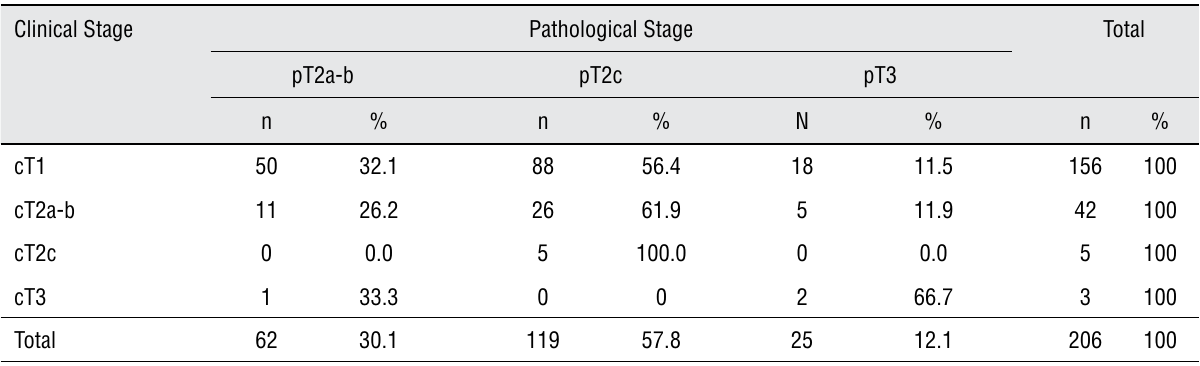
Table 4 - Relationship between clinical stage and pathological stage in single core PCa with GS ≤ 6. Clinical